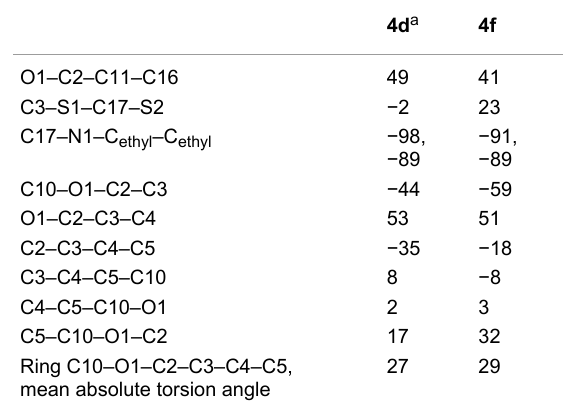
Table 3: Selected torsion angles (°, rounded to nearest degree) for 4d and 4f